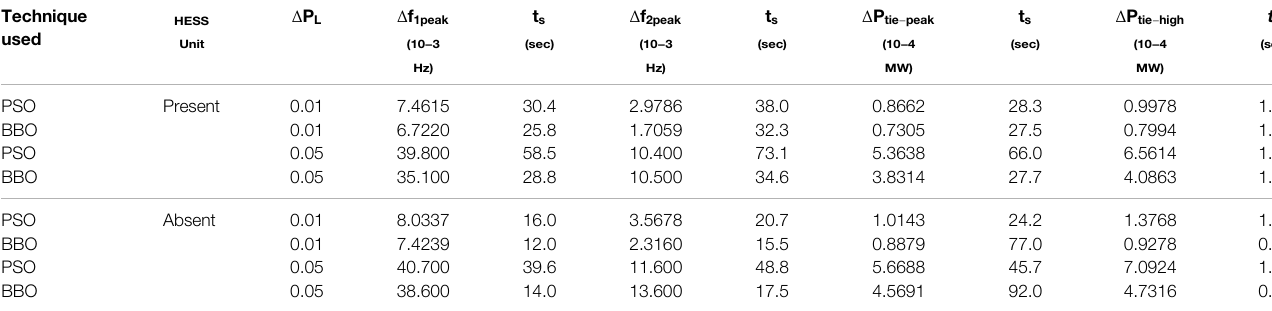
TABLE 2 | Performance analysis of the two-area interconnected system with VSP-HVDC line. Technique used